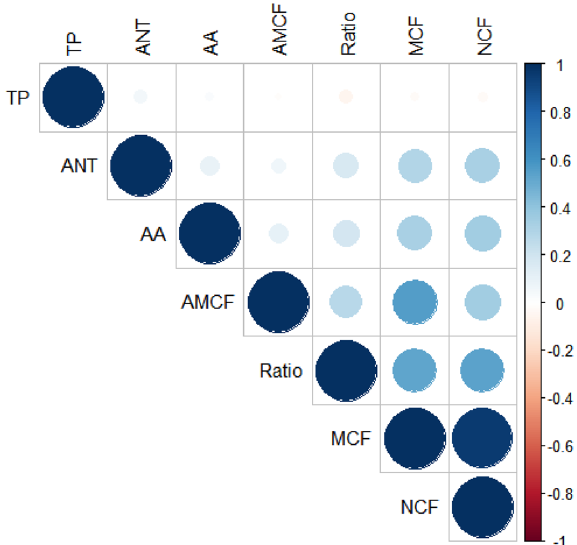
Figure 3. Pearson’s phenotypic correlations among yield and biochemical traits evaluated in 10 populations of Fragaria × ananassa Dusch. NCF number of commercial fruits (fruits plant −1 ), AMCF average mass of commercial fruits (g fruit −1 ), Ratio—soluble solids (Brix°)/titratable acidity (g citric acid 100 g −1 pulp), TP total pectin (g total pectin 100 g −1 pulp), AA ascorbic acid (mg ascorbic acid 100 g −1 pulp), and ANT anthocyanins (mg cyanidin-3-glucoside 100 g −1 pulp).